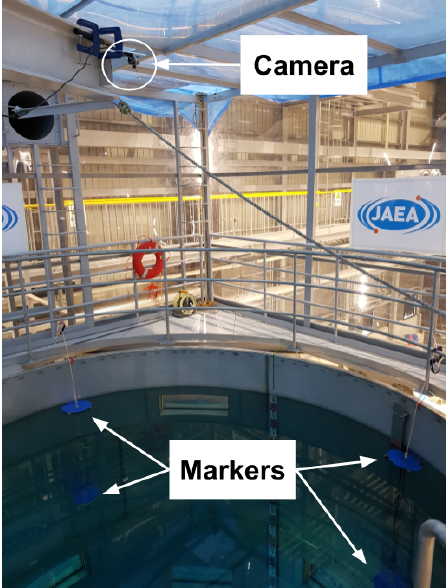
Figure 12. Setup of the camera in the Naraha Nuclear Test Facility.